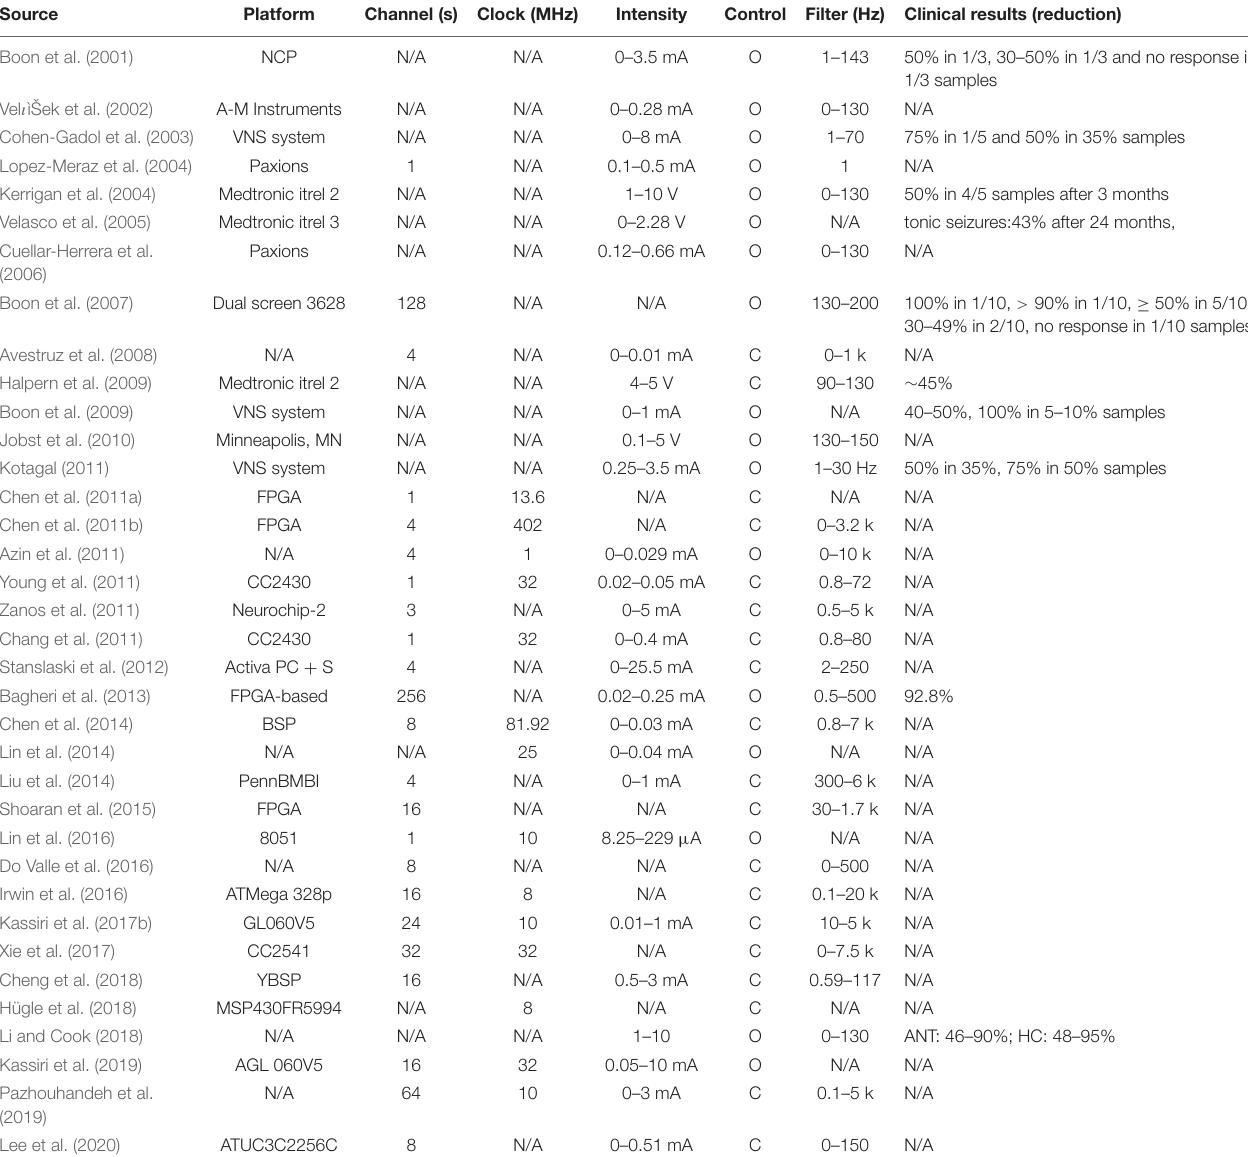
TABLE 4 | Recording and stimulation system for